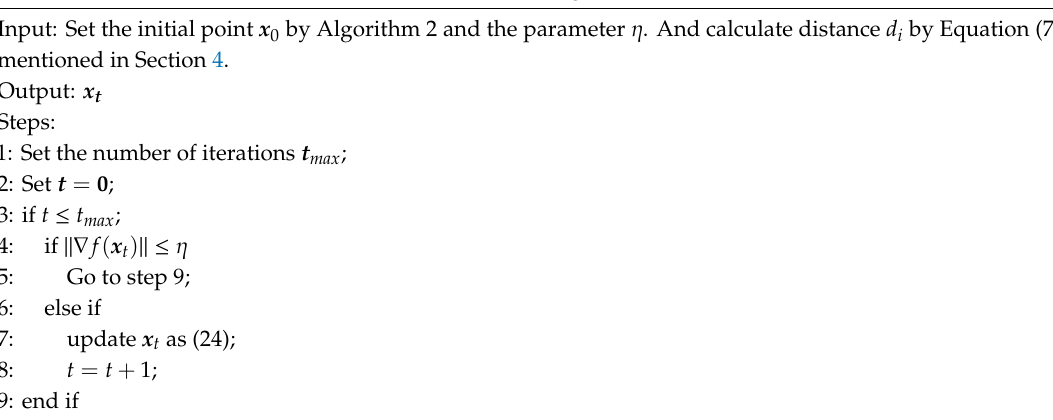
algorithm use Algorithm 2 as an initial point. The proposed acoustic-based localization algorithm joint T-MM with Algorithm 2 as described in detail in Algorithm 3. Algorithm 3 T-MM underwater acoustic-based location